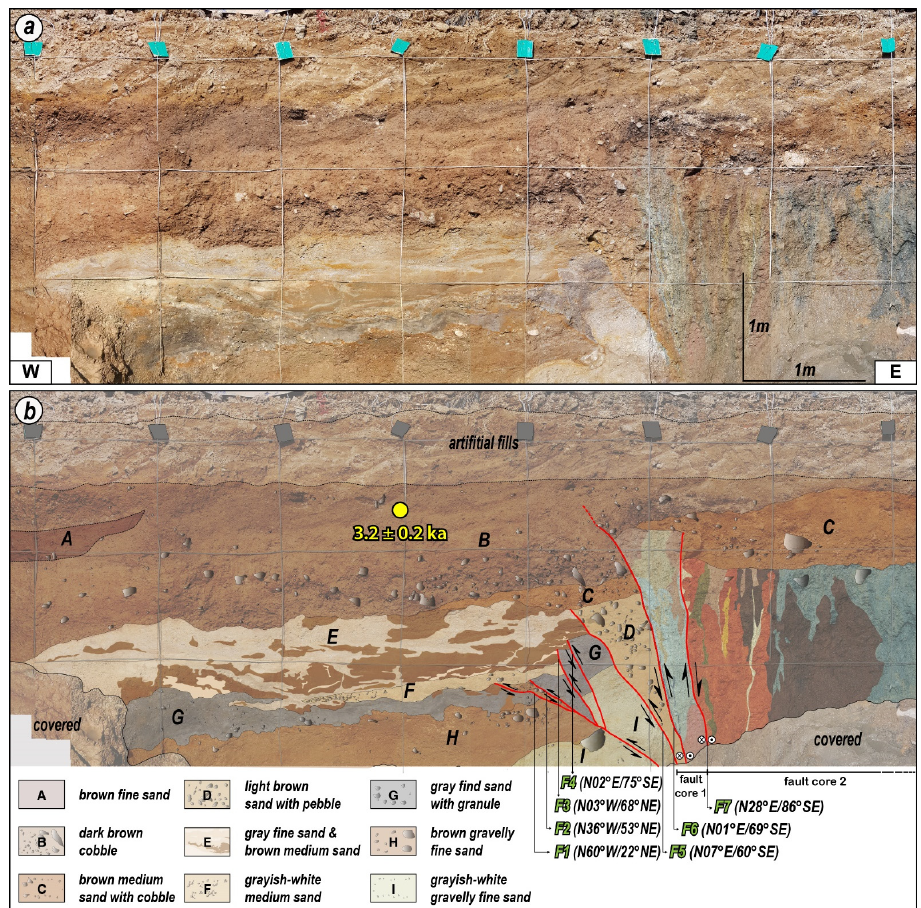
Figure 9. ( a ) Trench site photomosaic. ( b ) Trench sketch. Seven fault surfaces (red line) and nine deposit units are evident in the section. Division of unit B by the most recent faulting event (3200